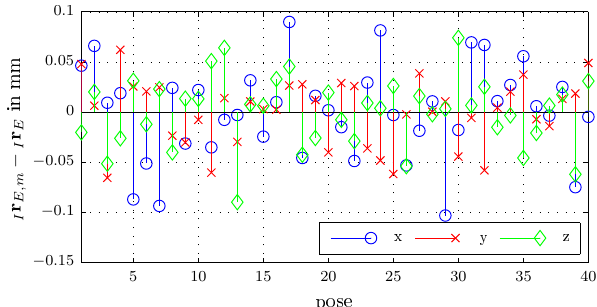
Figure 12. Error of the end-effector for the calibration poses in the inertial frame. PSfragrepla ements